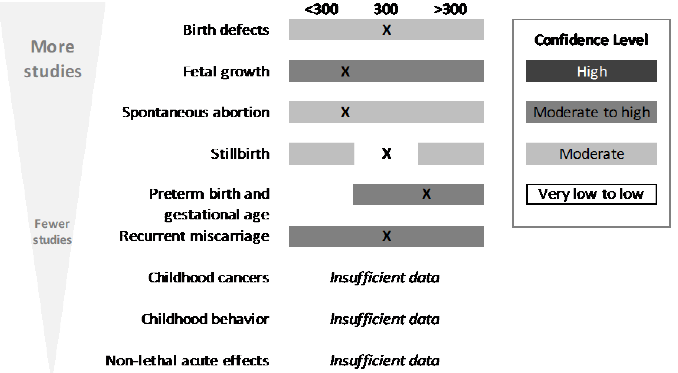
Figure 6. Summary of the spectrum of data and our endpoint conclusions specific to pregnant women, weighted for level of confidence in the body of evidence considering risk of bias, magnitude, consistency, etc. Shading indicates that data reported effects at the corresponding intake level (<300, 300, or >300 mg caffeine/day), and darker shading indicates increased confidence in the body of evidence (from very low to high). X indicates the weight-of-evidence conclusion. Although some effects were seen at intakes lower than 400 mg (e.g., fetal growth, spontaneous abortion), these results did not affect the overall conclusion of the SR due to considerable variability in findings and potential